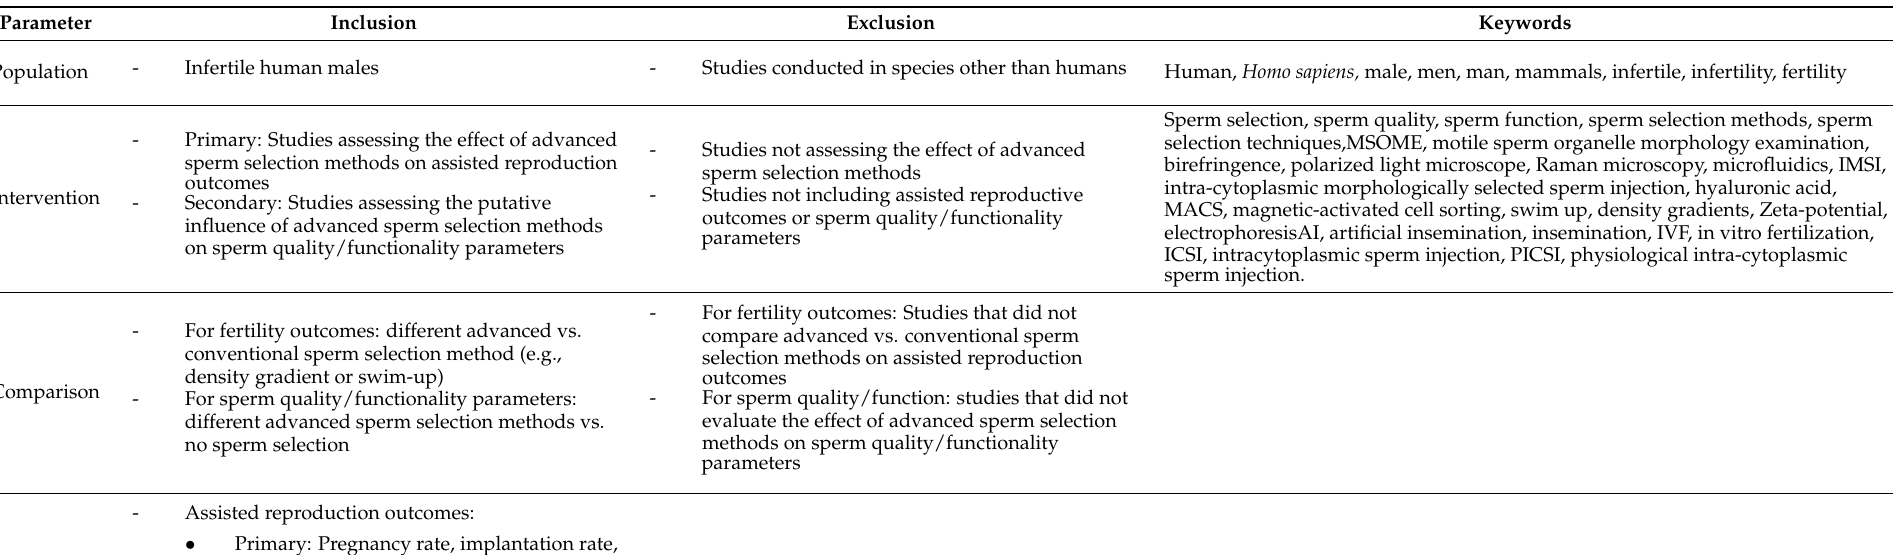
Table 1. Population, intervention, comparison, outcome, and study (PICOS) design, comprising inclusion and exclusion criteria and the keywords used for the definition of the search strategy and the eligibility of the